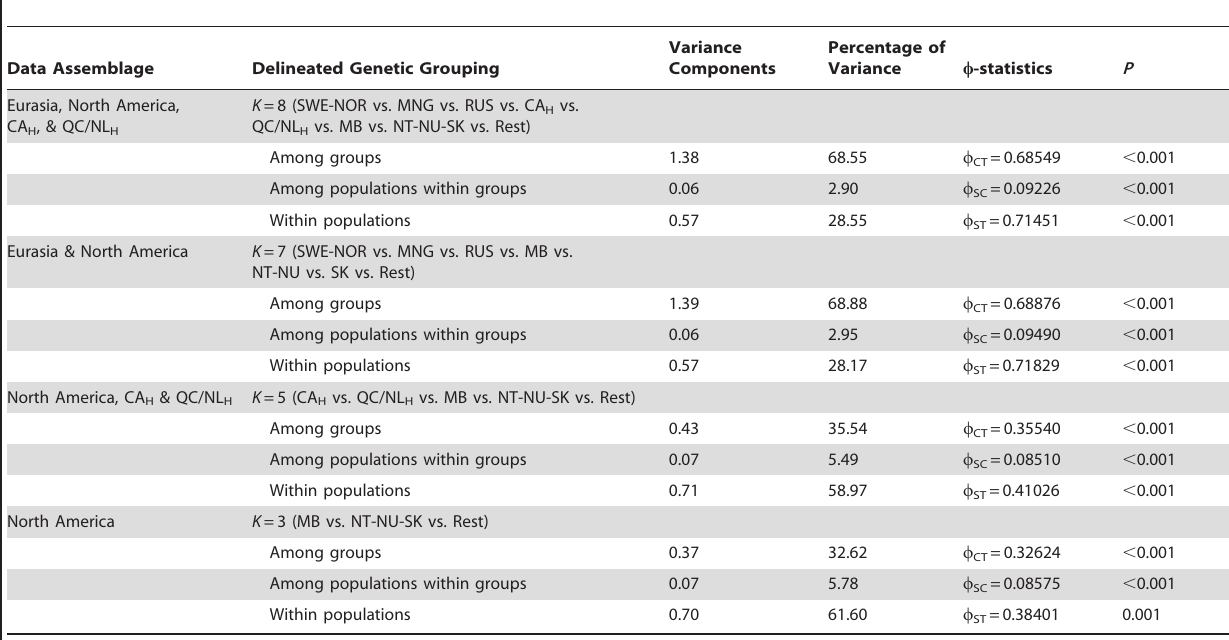
Table 3. Results of delineated genetic groupings identified by SAMOVA for different population configurations.